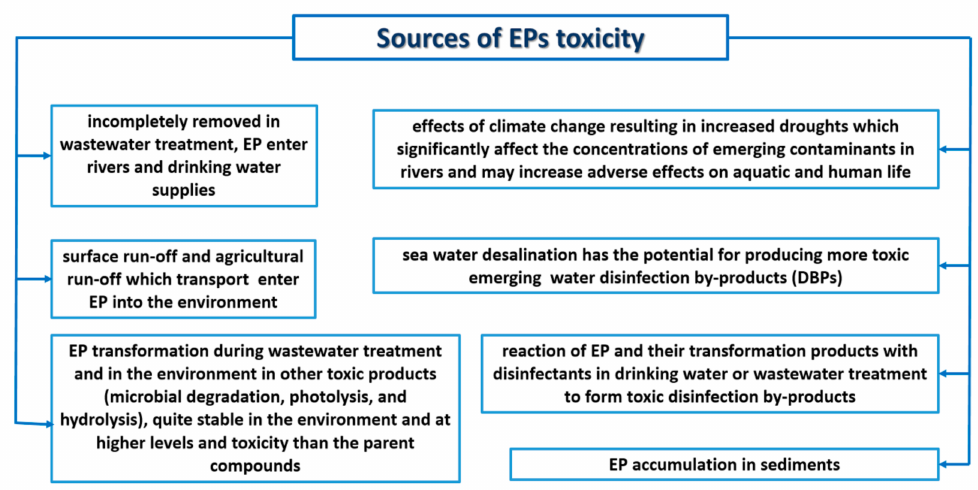
Figure 4. Incidence of emerging pollutants’ (EPs) toxicity from various sources of pollution (hazards), which can generate environmental and human